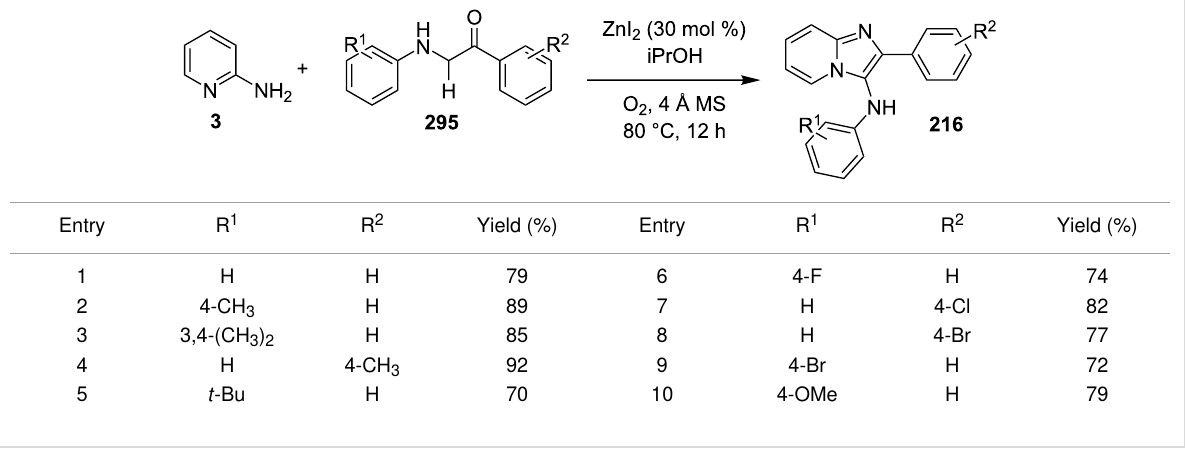
Table 12: Formation of 3-aminoimidazo[1,2- a ]pyridines from α -aminocarbonyl compounds.